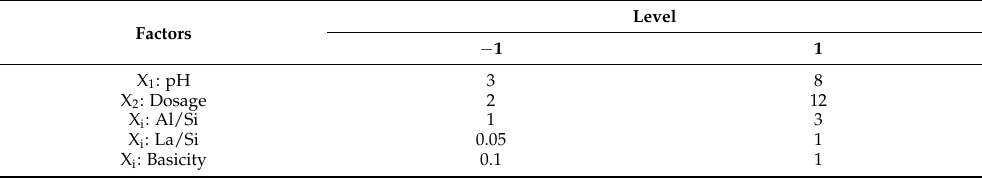
Table 2. Coded levels for variables in